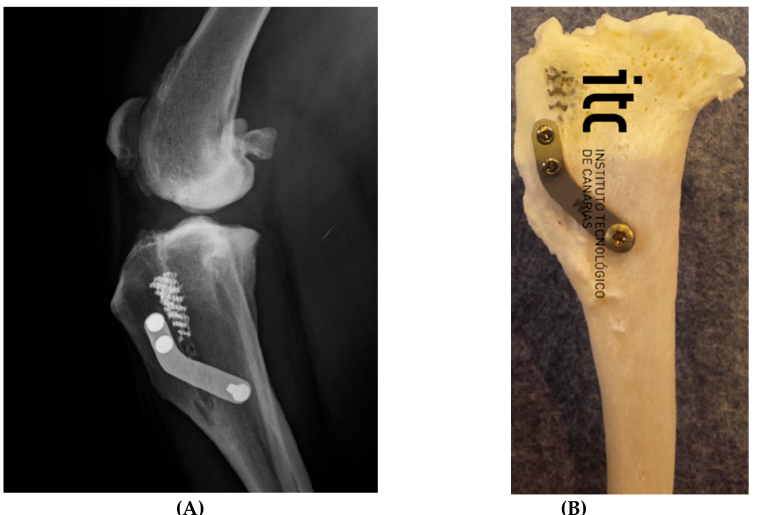
Figure 7. The osteointegration of porous titanium cage. ( A ) Mediolateral projection of a dog who had undergone Porous TTA. Control after three years. ( B ) Post mortem aspect of the integration of bone and scaffold (two years after surgery).